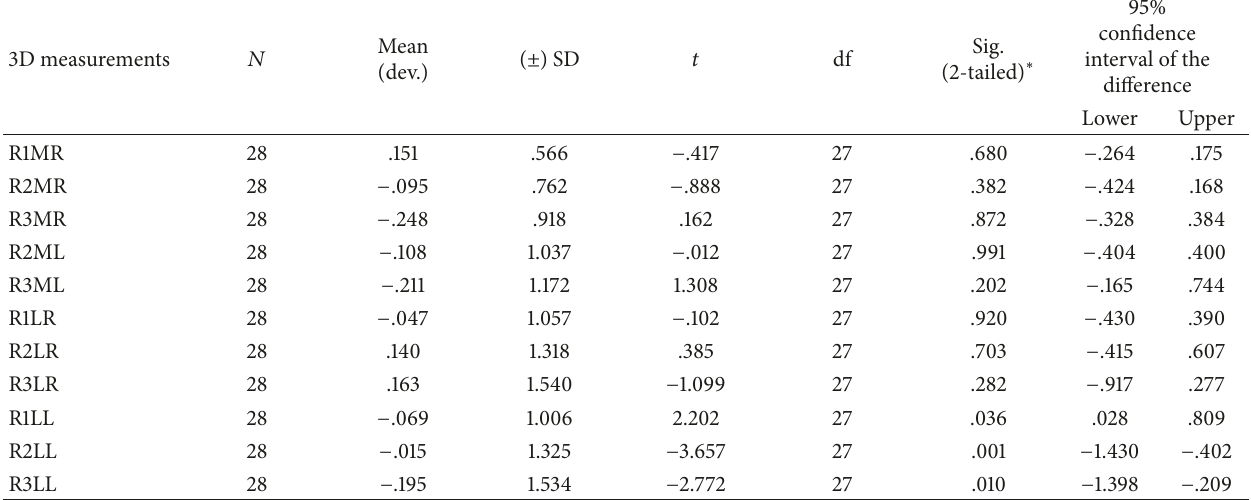
Table 3: One-sample t -test results from the deviation magnitude comparison of identical twins and different individual values. 3D measurements 𝑁